Question: What type of chart is this?
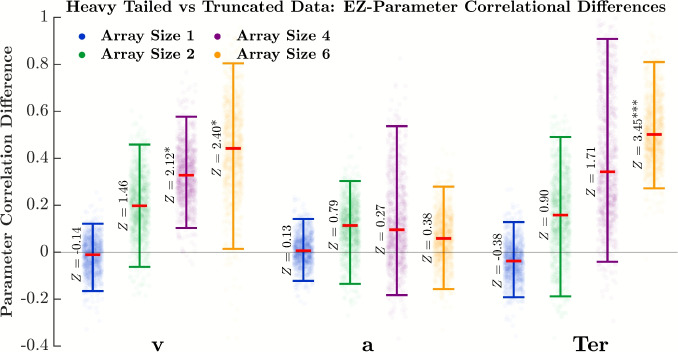
Answer: bar